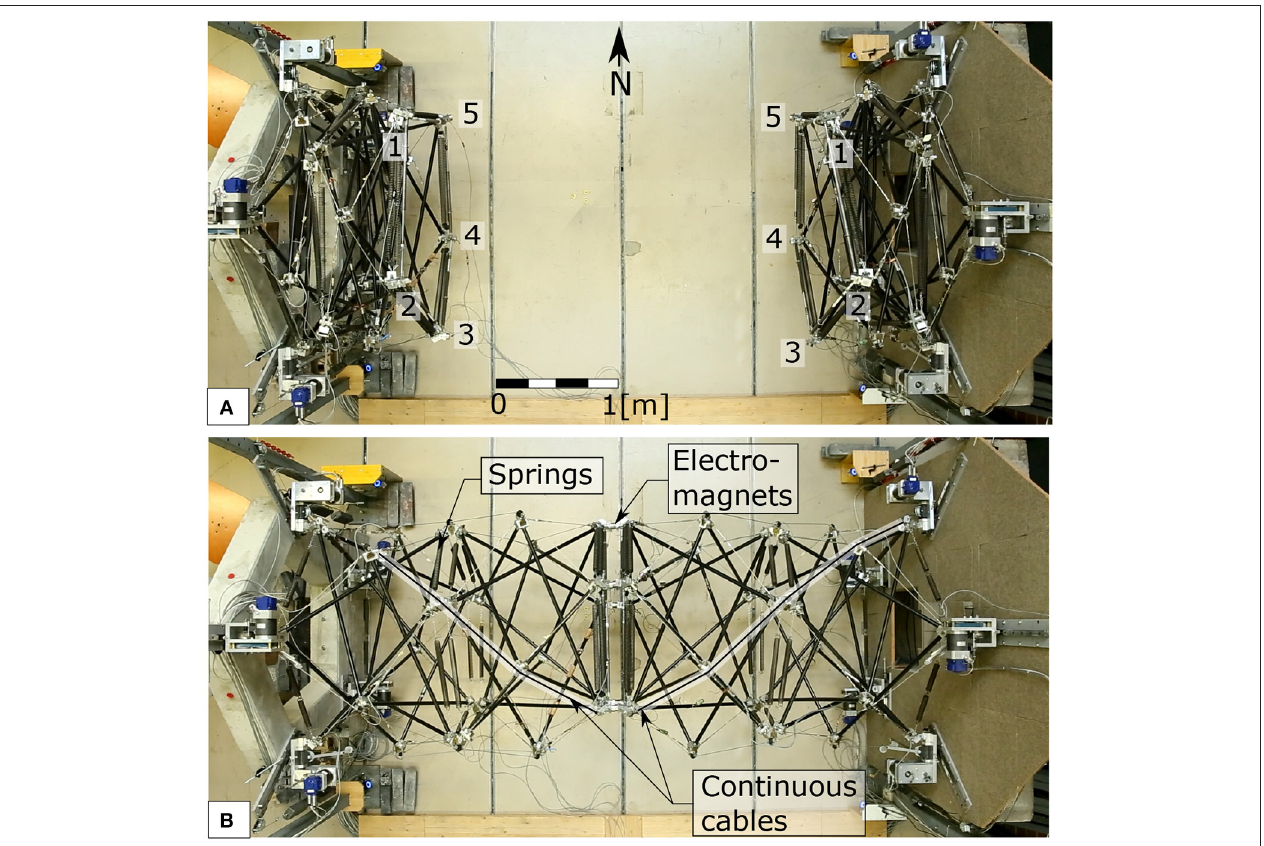
FIGURE 2 | Top view of the tensegrity structure before (A) and after (B) deployment and connection at midspan using electromagnets. Actuation is facilitated by continuous cables and springs on each half of the structure [Credit: IMAC,